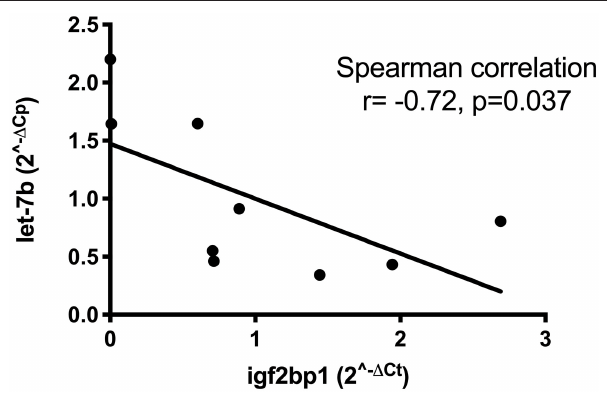
FIGURE 2 | Correlation between low let-7b expression and high expression of IGF2BP1 in eight osteosarcoma tumors as determined by